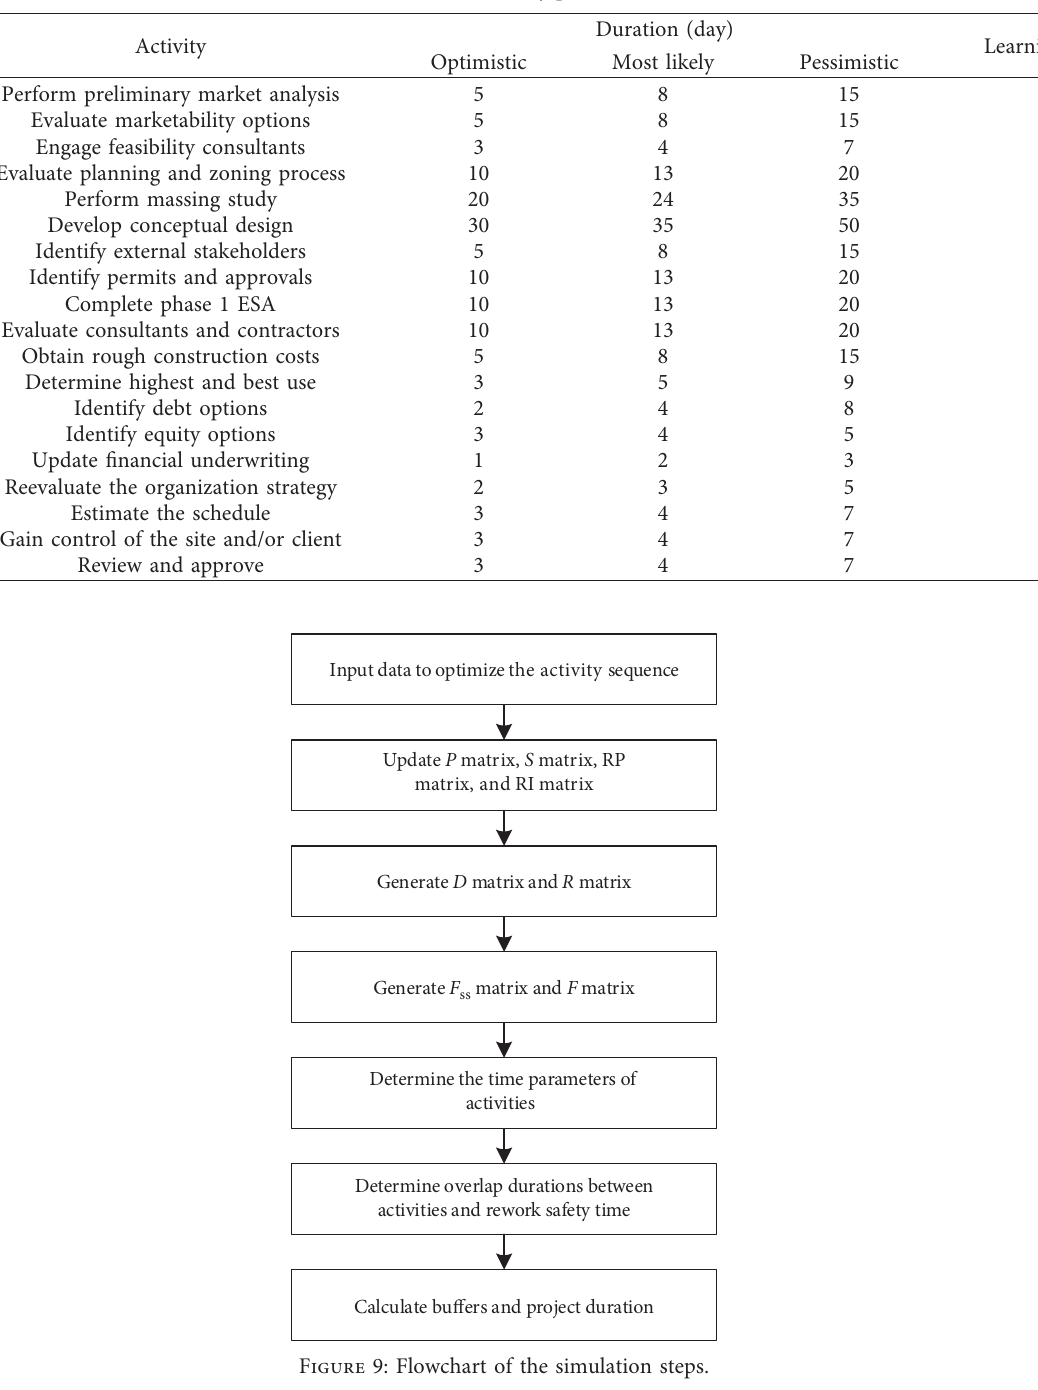
Table 3: Case activity parameters.